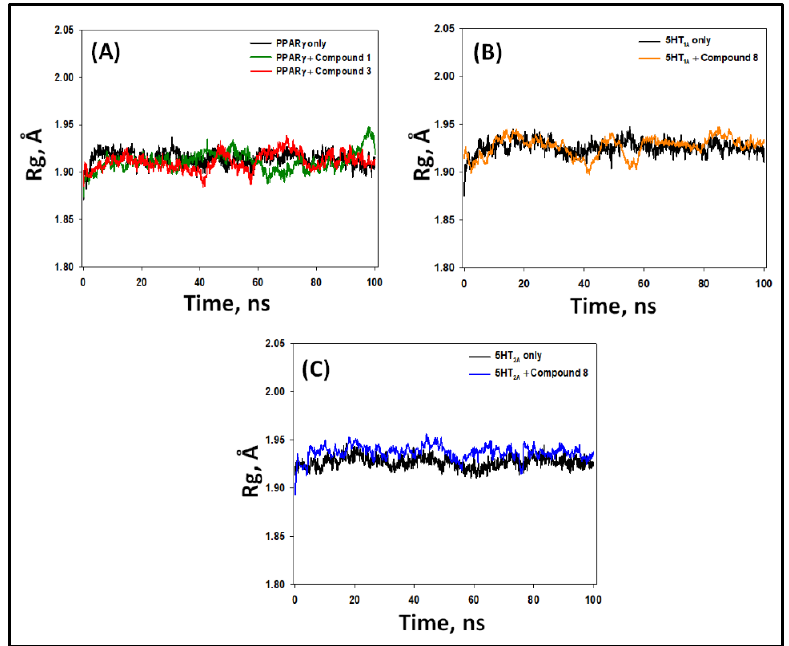
Figure 11. Variation in radius of gyration (Rg) of PPAR- γ, 5-HT 1A , and 5-HT 2A with their respective compounds. ( A ) PPAR- γ alone and in the presence of compounds 1 and 3 ; ( B ) 5-HT 1A alone and in the presence of compound 8 ; ( C ) 5-HT 2A alone and in the presence of compound 8.